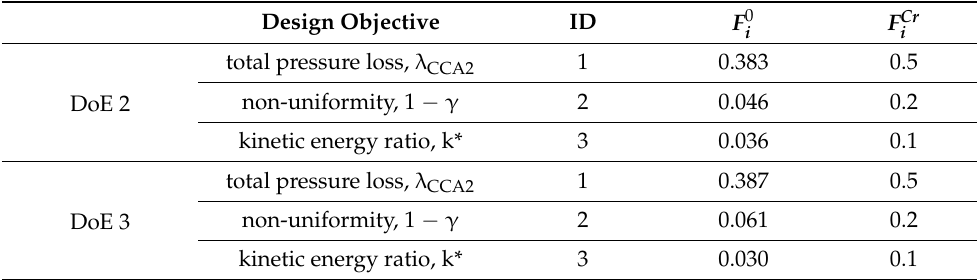
Table 5. Scaling parameters for DoE 2 and DoE